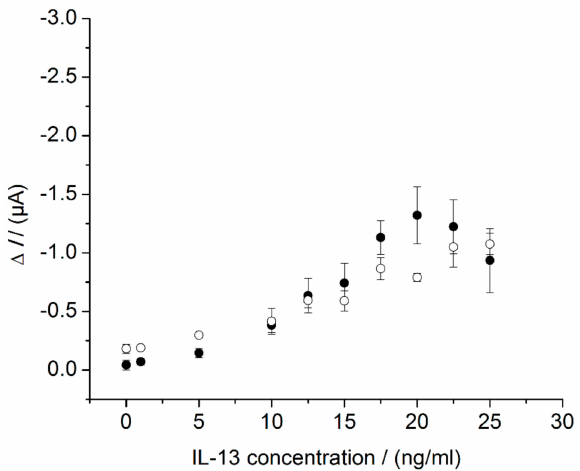
Figure 7. Comparison of immunosensor characteristics in beaker and in flow cell. Three different immunosensors prepared in the same manner (triplicates) for each concentration. Amperometric measurements performed at 0.0 V. Measurements in beaker (black circles) in 10 mL of 1 mM hydroquinone in 0.1 M PBS pH 6, after addition of 100 µ L of 50 mM hydrogen peroxide in 0.1 M PBS pH 6. Measurements in flow cell (white circles) with continuous flow of 1 mM hydroquinone in 0.1 M PBS pH 6 with 0.8 mL/min, injection flow of 1.5 mM hydrogen peroxide in 0.1 M PBS pH 6 with 0.4 mL/min and